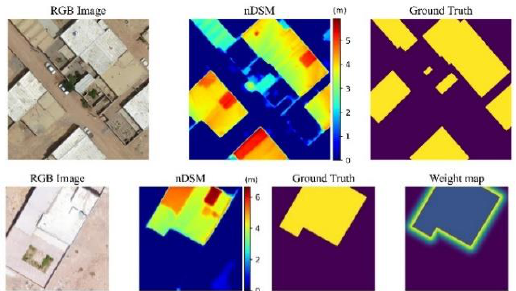
Figure 3 . Test (the first row) and train (the second row) data.